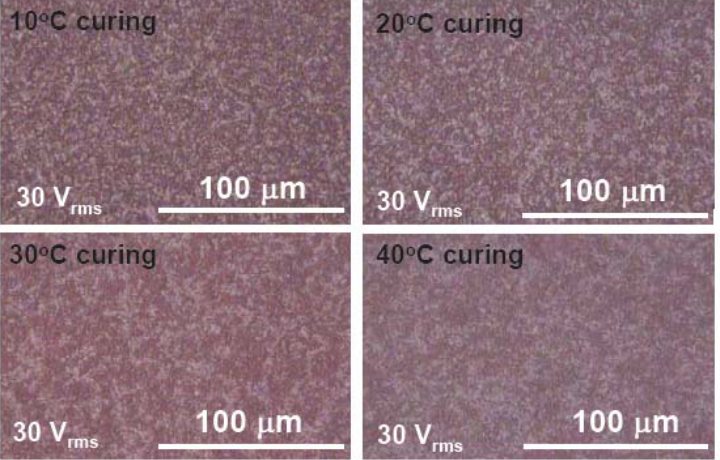
Figure 4. The microscopic images of dye-doped LC gels with various curing temperature. The applied voltage is 30 V rms